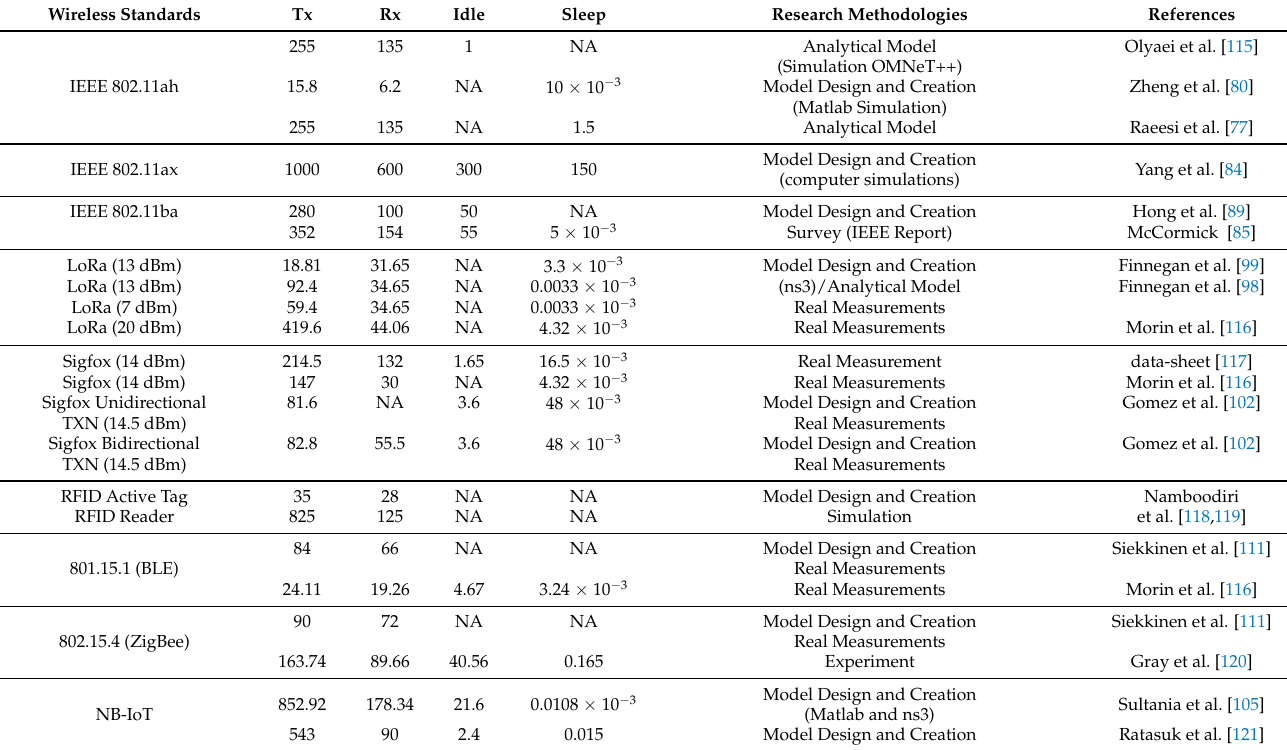
Figure 4. Overview of the MAC protocols of the current IoT technologies. Table 3. Power consumption for IoT technologies